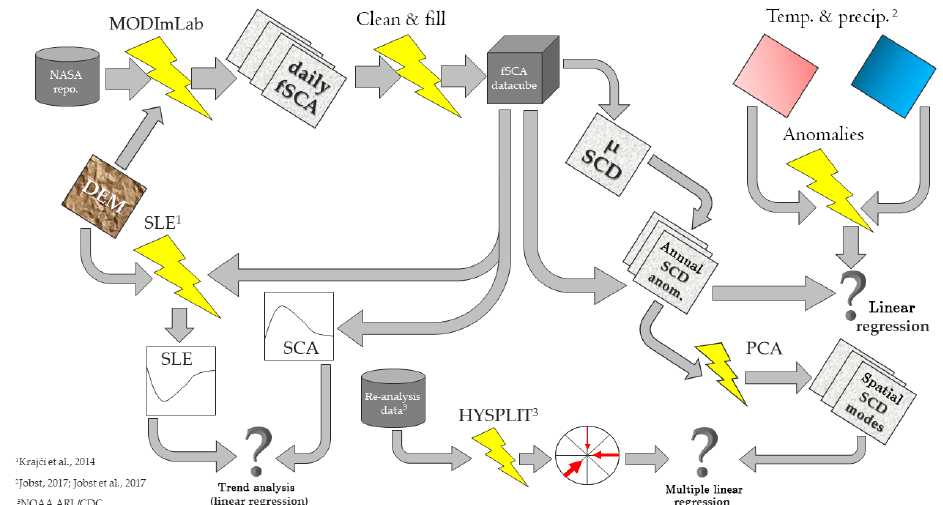
Figure 2. MODIS imagery processing chain and subsequent processing (“lightning bolt” symbols) and analytical steps applied. The fractional snow-covered area (fSCA) data cube facilitates the determination of daily snowline elevation (SLE) and snow-covered area (SCA). The mean snow cover duration ( µ SCD) calculated over the length of the time series provides the basis for calculating annual SCD anomalies. Along with spatial SCD modes from PCA analysis these form the basis for assessing the importance of climatic forcings on spatio-temporal variability in